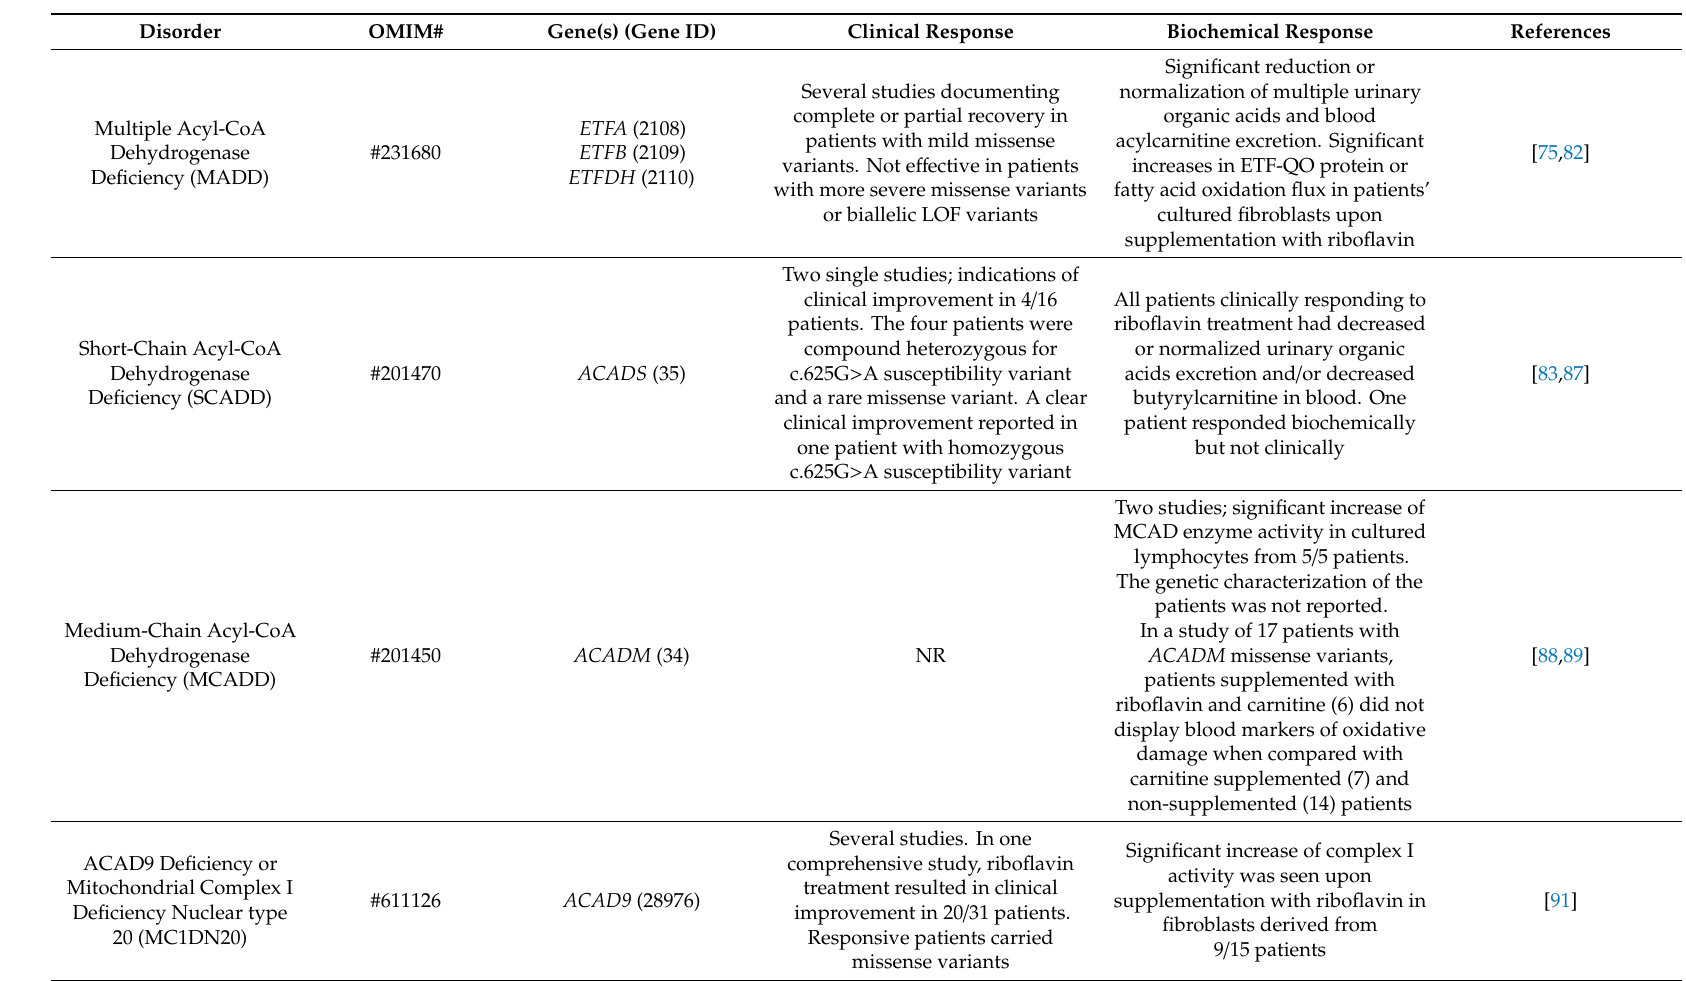
Table 1. Overview of riboflavin-responsive